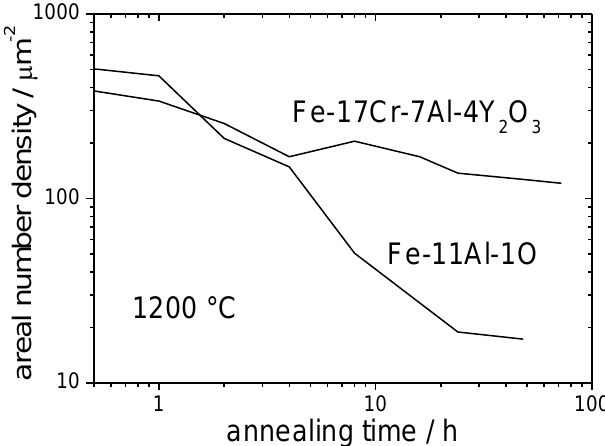
Figure 10. Evolution of areal number densities of oxides in both systems.